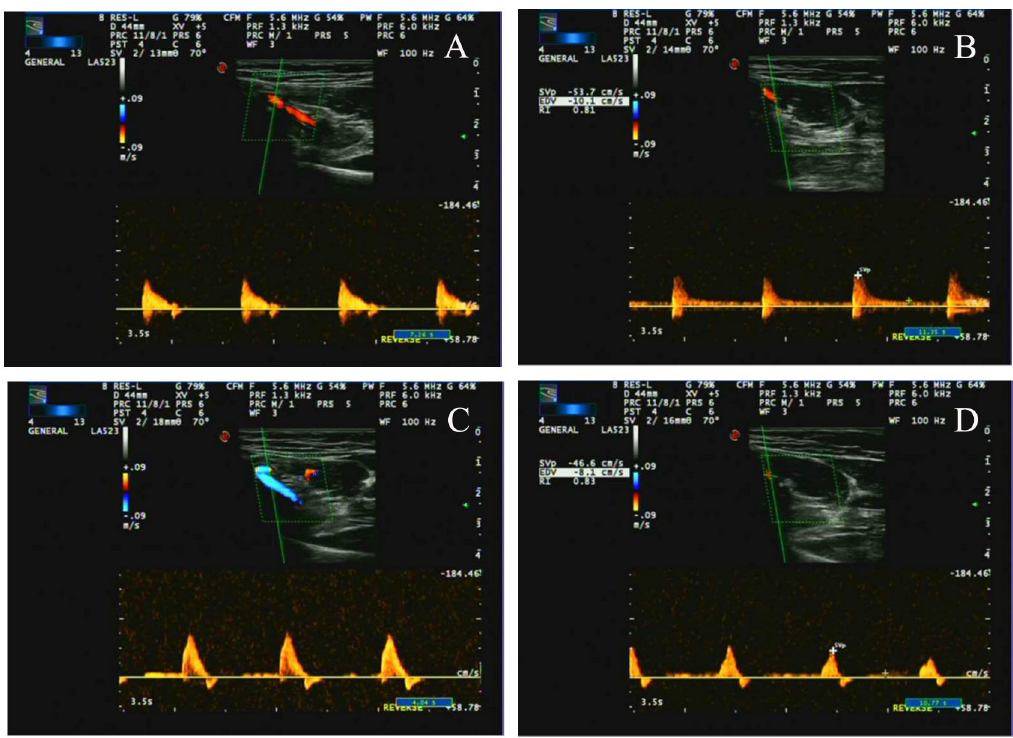
Figure 2: Radial artery blood flow before and after isometric exercise training (A,B); Radial artery blood flow before and after cuff inflation training